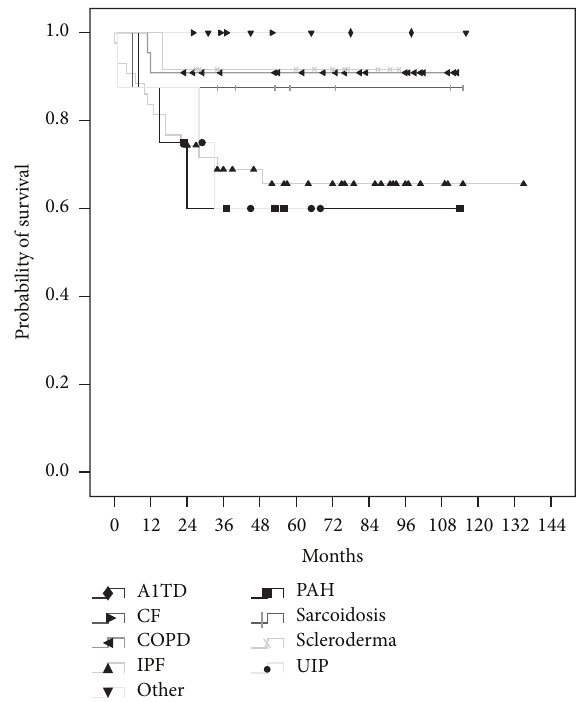
Figure 5: Kaplan-Meier curve shows that there is no significant difference in survival between primary lung pathology